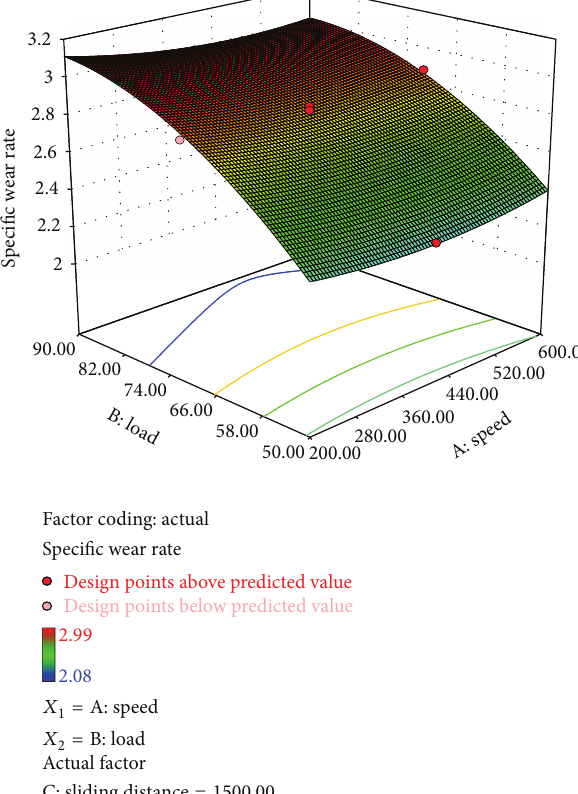
Figure 3: 3D response plot for specific wear rate (mm 3 /Nm) with the change of applied normal load and sliding